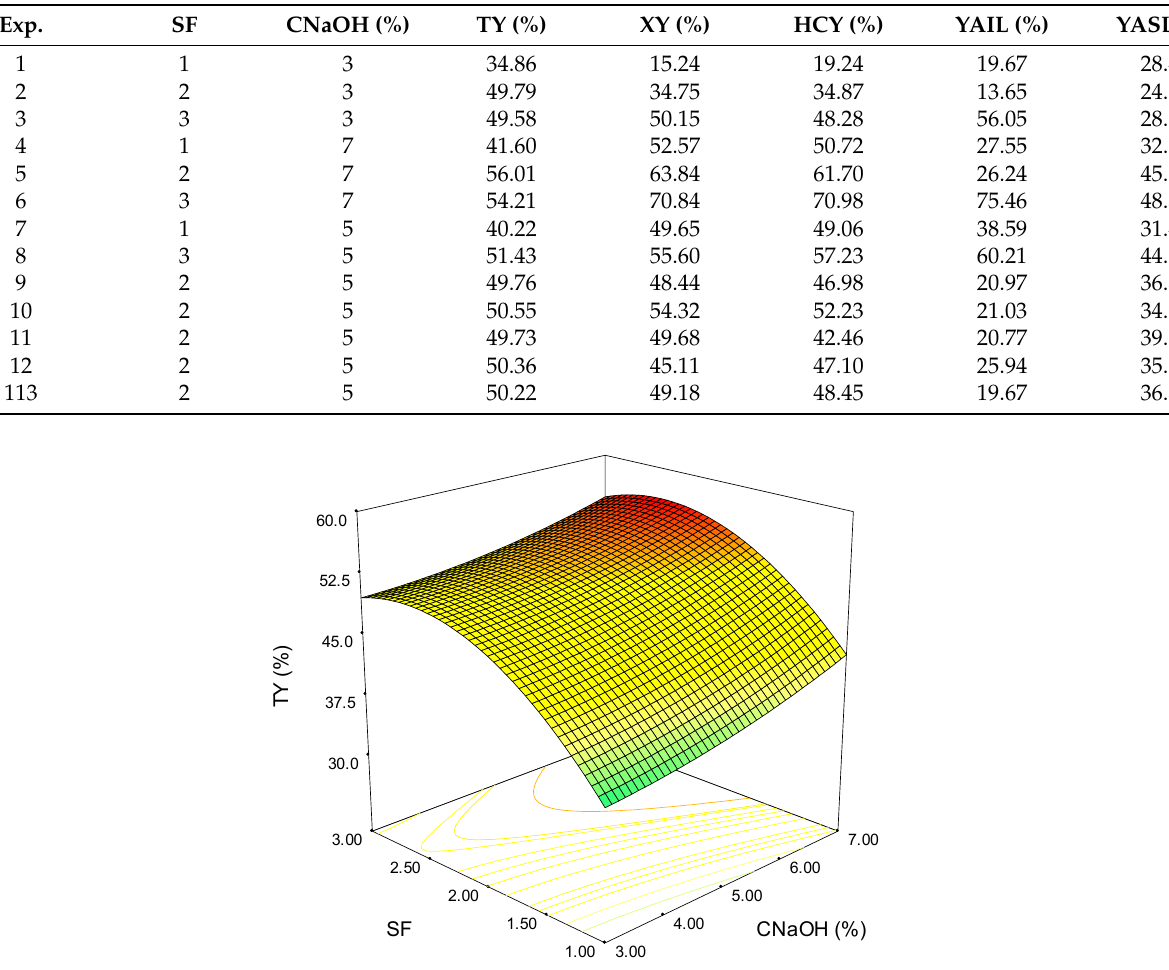
Figure 2. Variation of homoxylan extraction yield as a function of severity factor and alkali concen- tration (the colours green-yellow-red indicate the shift from low to high values). Figure 3 shows the response surface of the model for the total hemicelluloses extrac- tion yield. Similar behavior as in the case of XY (%) can be observed for HCY (%); the highest extraction yield being obtained at maximum values for SF and CNaOH. However, the individual influence of the considered variables is slightly different (indicated by the slopes of the surface in relation to each parameter).